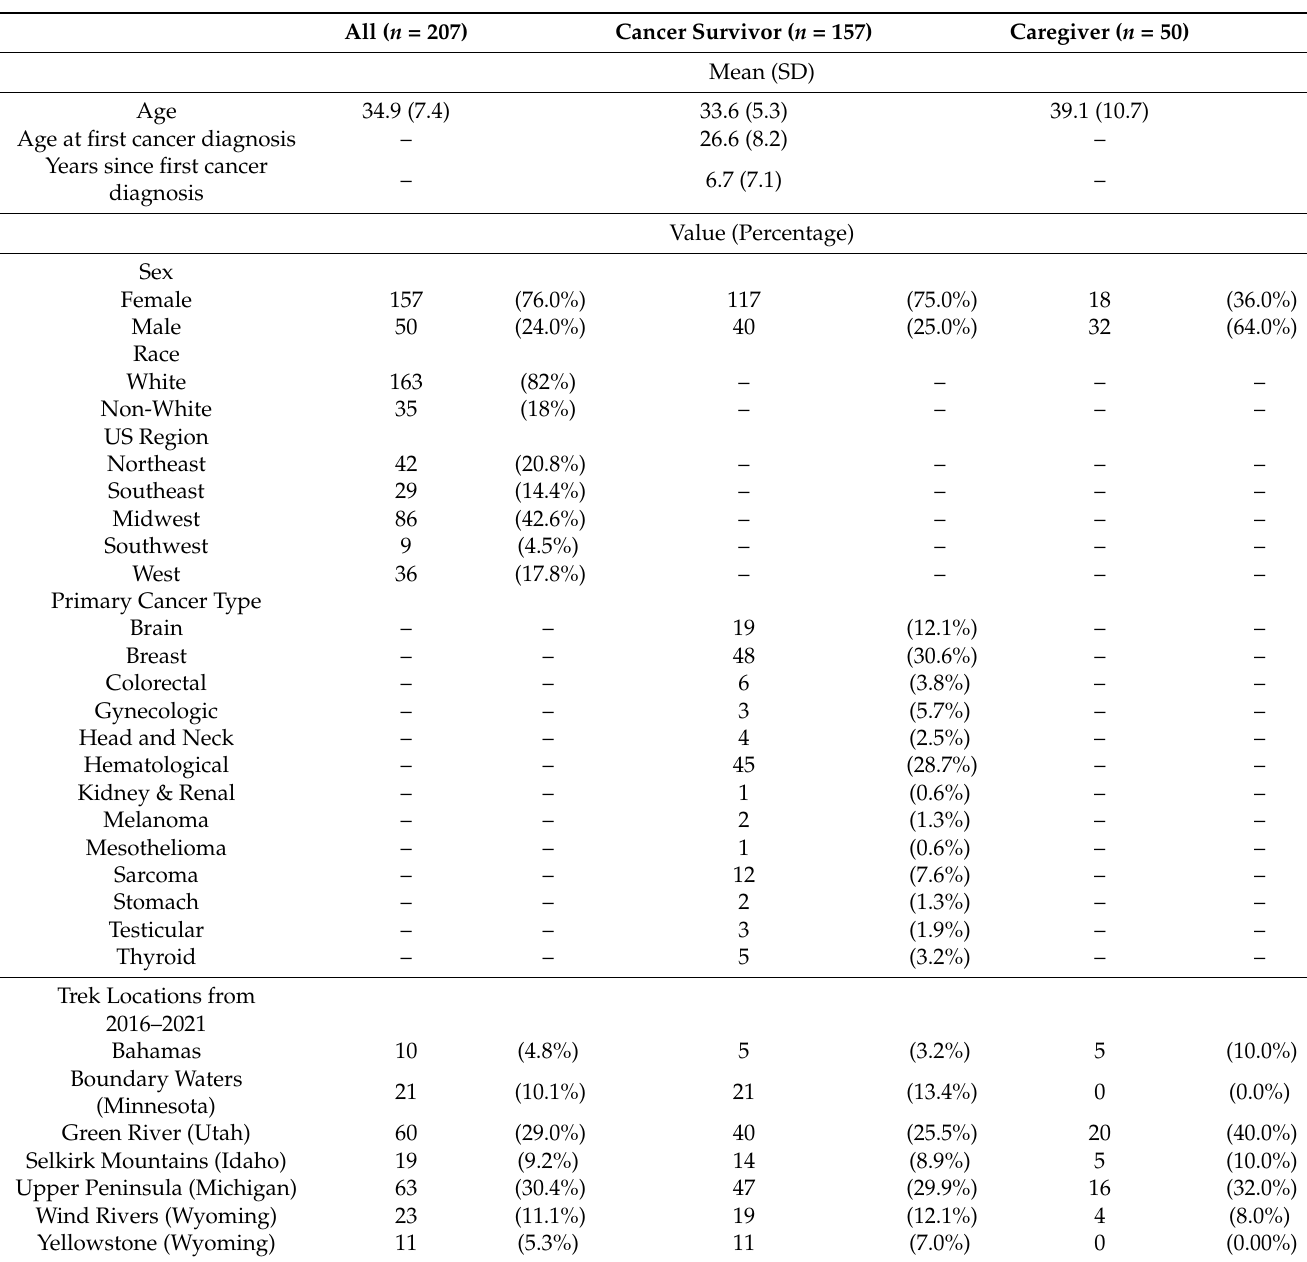
Table 1. Socio-Demographic and Cancer-Related Characteristics of Participants